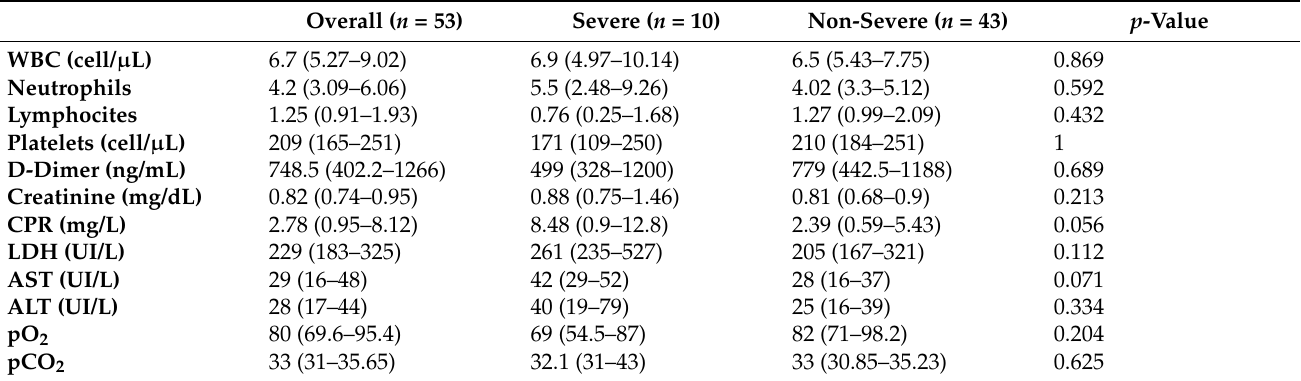
Table 3. Laboratory data are showed as median (IQR 25–75), a Mann–Witney test was used ( α <